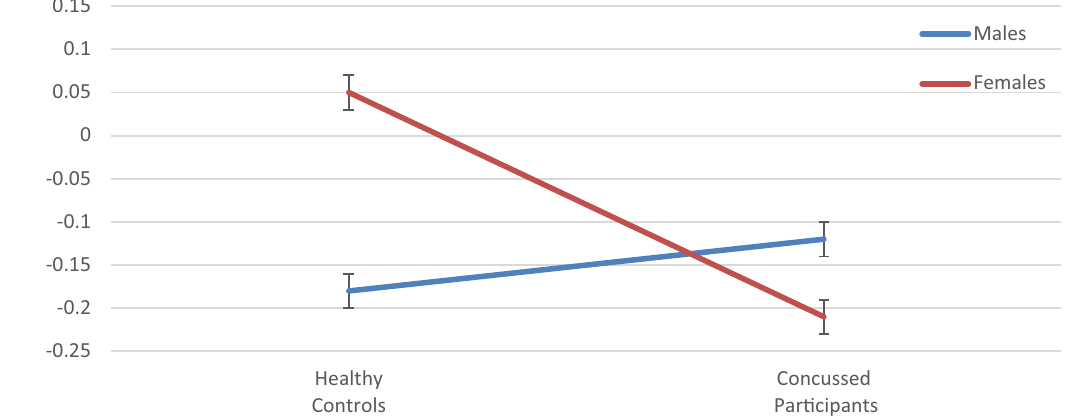
Figure 3. Sex (males > females) × injury (concussed > controls) interaction for seed-to-network connectivity of the right lateral prefrontal cortex, a node of the FPN, with ( A ) the left superior temporal gyrus (posterior division) and ( B ) the left planum